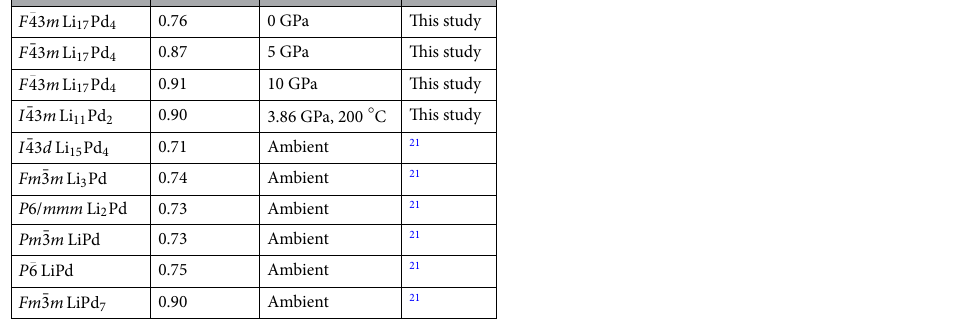
Table 2. Comparison of the ratio of the volume of various lithium–palladium intermetallics to the volume of an equivalent quantity of elemental lithium and palladium. Temperature is ambient except where noted. Volumes for Li 17 Pd 4 from this study are based on its equation of